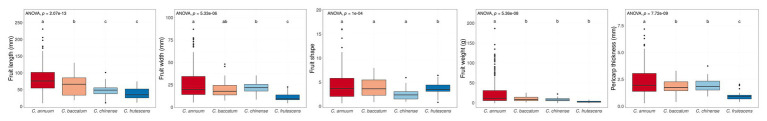
Box plots of four fruit-related traits grouped by species. We investigated the phenotype of the core collection, which contained only one Capsicum chacoense accession so, the phenotype of C. chacoense was excluded. Boxes indicate the range of upper quartile and lower quartile, and the bar in the box is the median. Whiskers from upper quartile to maximum and lower quartile to minimum are vertical lines. Black spots are outliers. The small alphabets showed the difference among the species. These significances were calculated by Dancan’s least significant range (LSR) test. The core collection has a distinct population structure by species. These phenomena were commonly observed for all four traits.